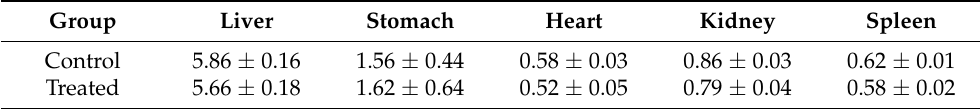
Table 8. Absolute weight of different vital organs (g) in control and TRHC-PAG-alginate microspheres treated